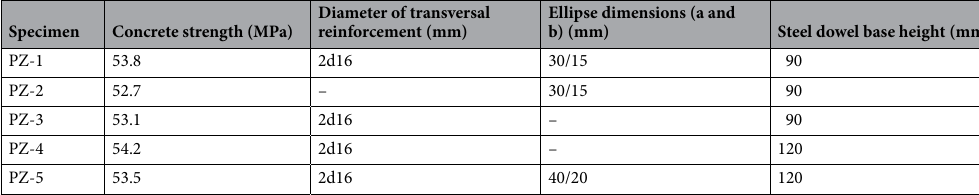
Table 2. Parameters of PZ shape shear connector